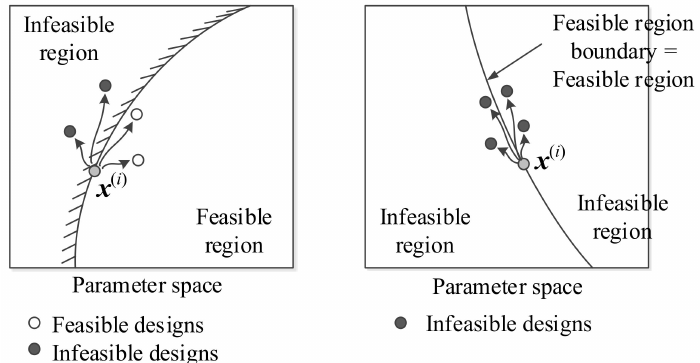
Figure 15. Design relocation from feasible region boundary for inequality and equality constraints: ( a ) inequality constraint: the designs produced from the current design x ( i ) may be located in either feasible or infeasible region, ( b ) equality constraint: essentially all designs produced from x ( i ) are infeasible due to feasible region being a thin set. Consequently, exploration of the feasible space is more difficult for the equality constraints than the inequality